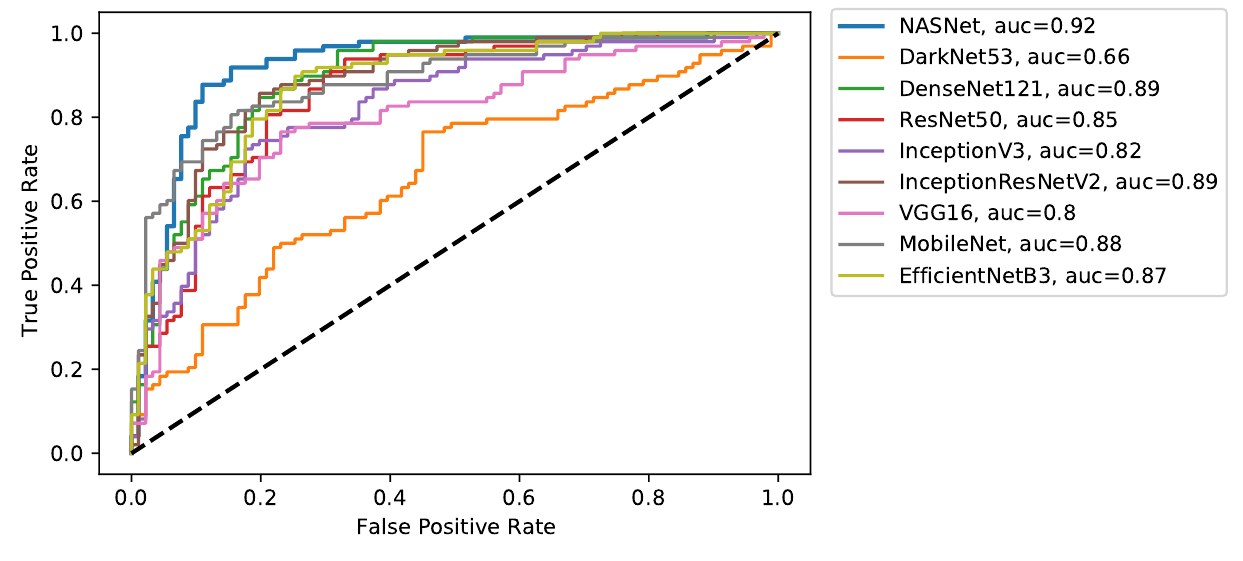
Figure 5. ROC curves for implemented deep learning models.